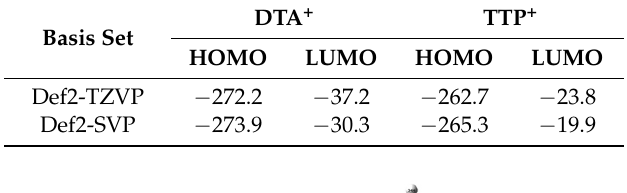
Table 2. The frontier molecular orbital eigenvalues of the DTA + and TTP + collectors at wB97XD/Def2- TZVP level, unit is in Kcal/mol.